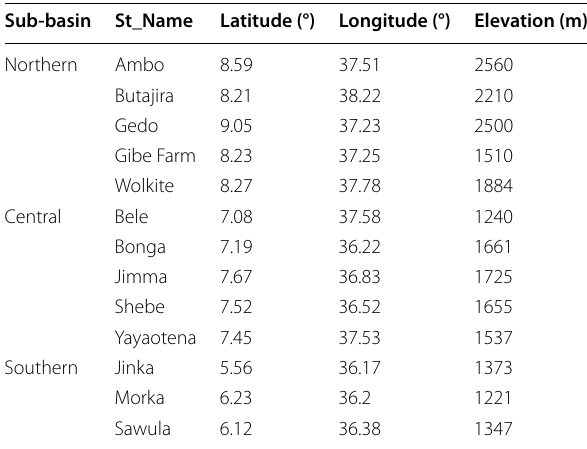
Table 1 Meteorological stations of OGRB according to the three